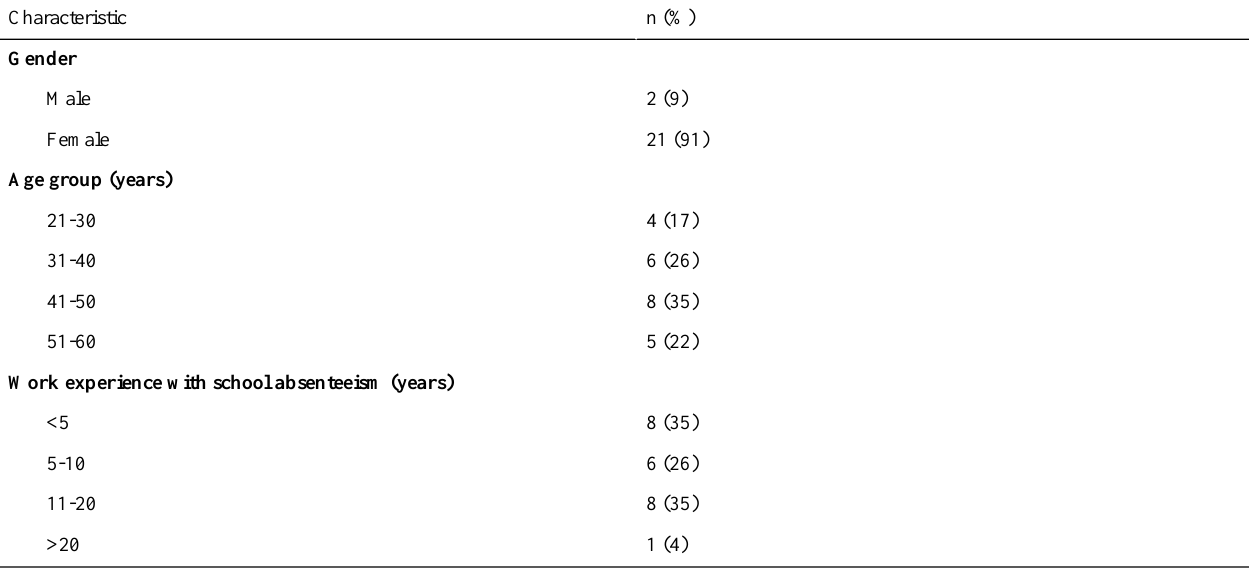
Table 1. Sample characteristics of professionals (n=23).